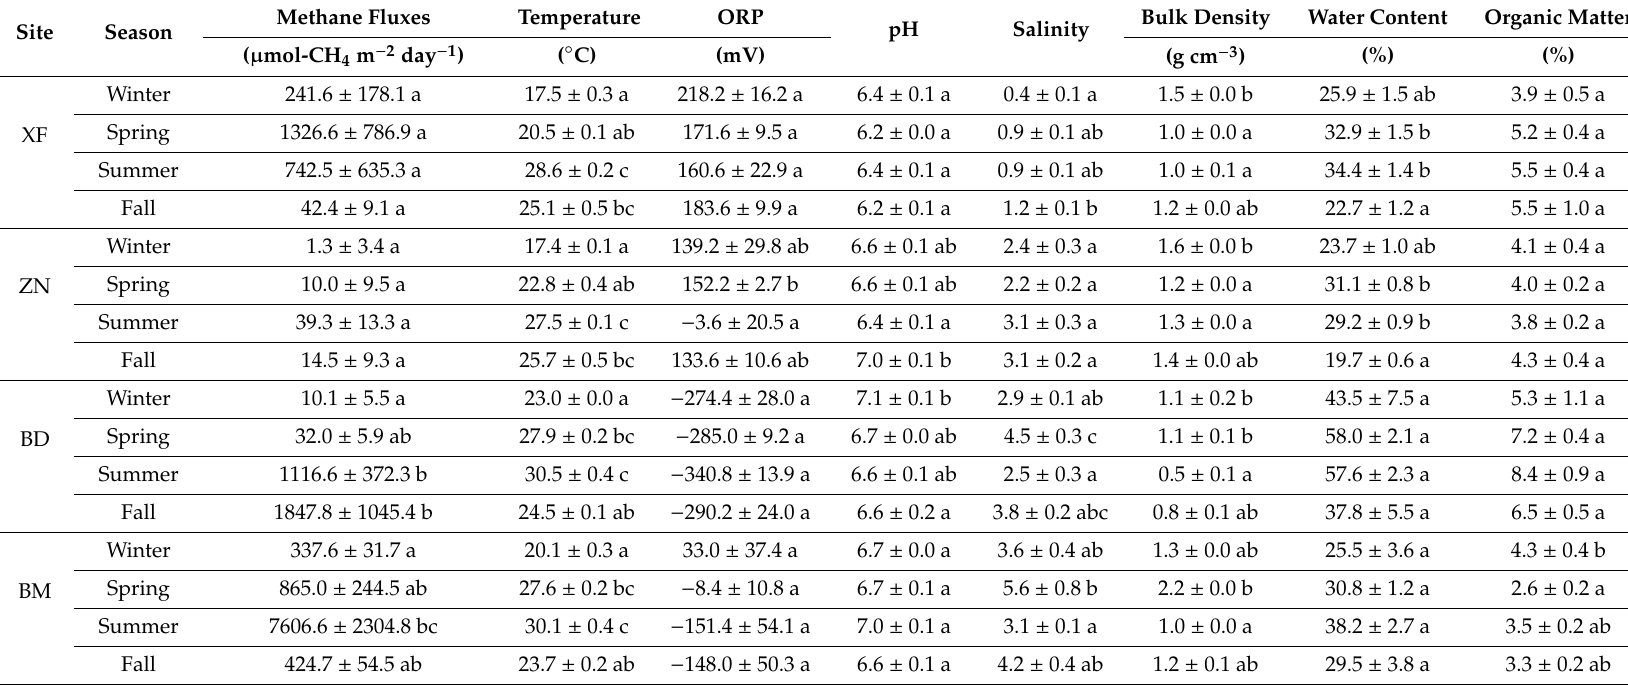
Table 2. Seasonal variations in methane fluxes and soil physiochemical parameters (Mean ± standard error) of the four mangrove sites. Di ff erent letters indicate significant seasonal di ff erences with the Kruskal–Wallis test and Tukey’s honestly significant di ff erence (HSD) test and the Bonferroni correction for the significance level for each mangrove site. ORP: redox